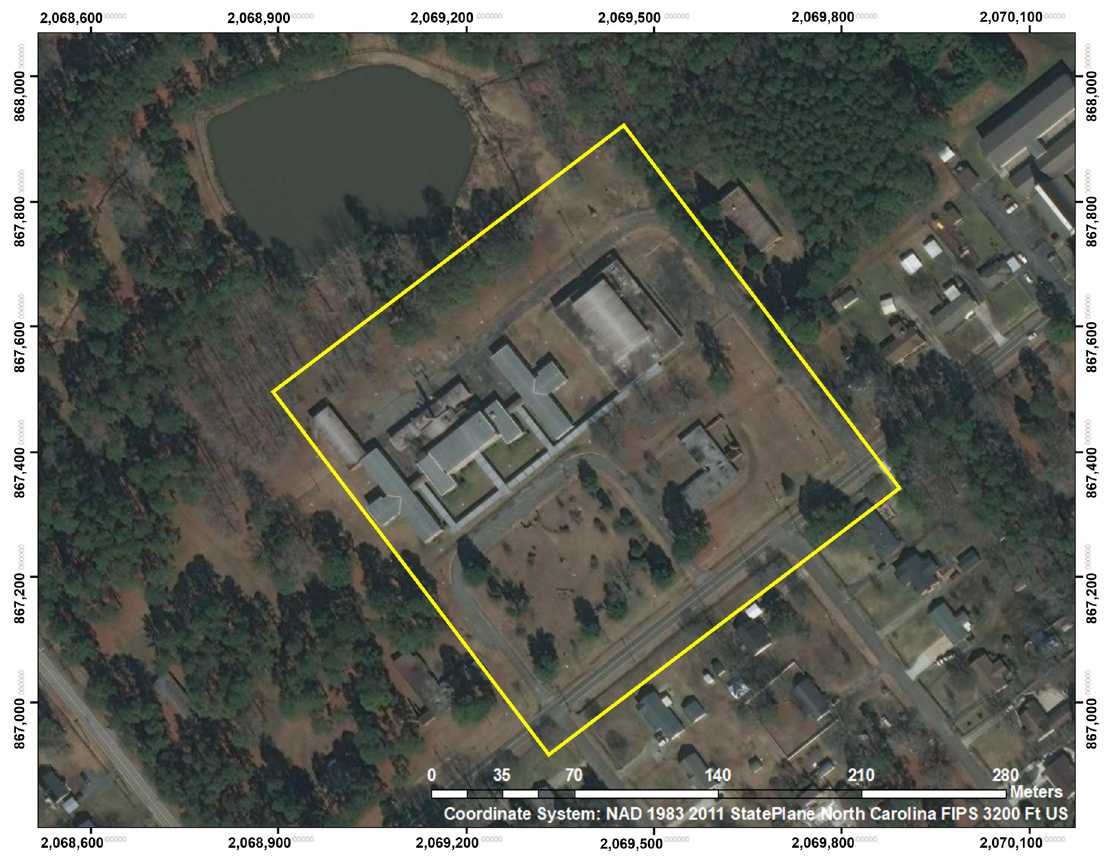
Figure 7. Butner Site Conditions (Flat surface with buildings, open spaces, and vegetation).